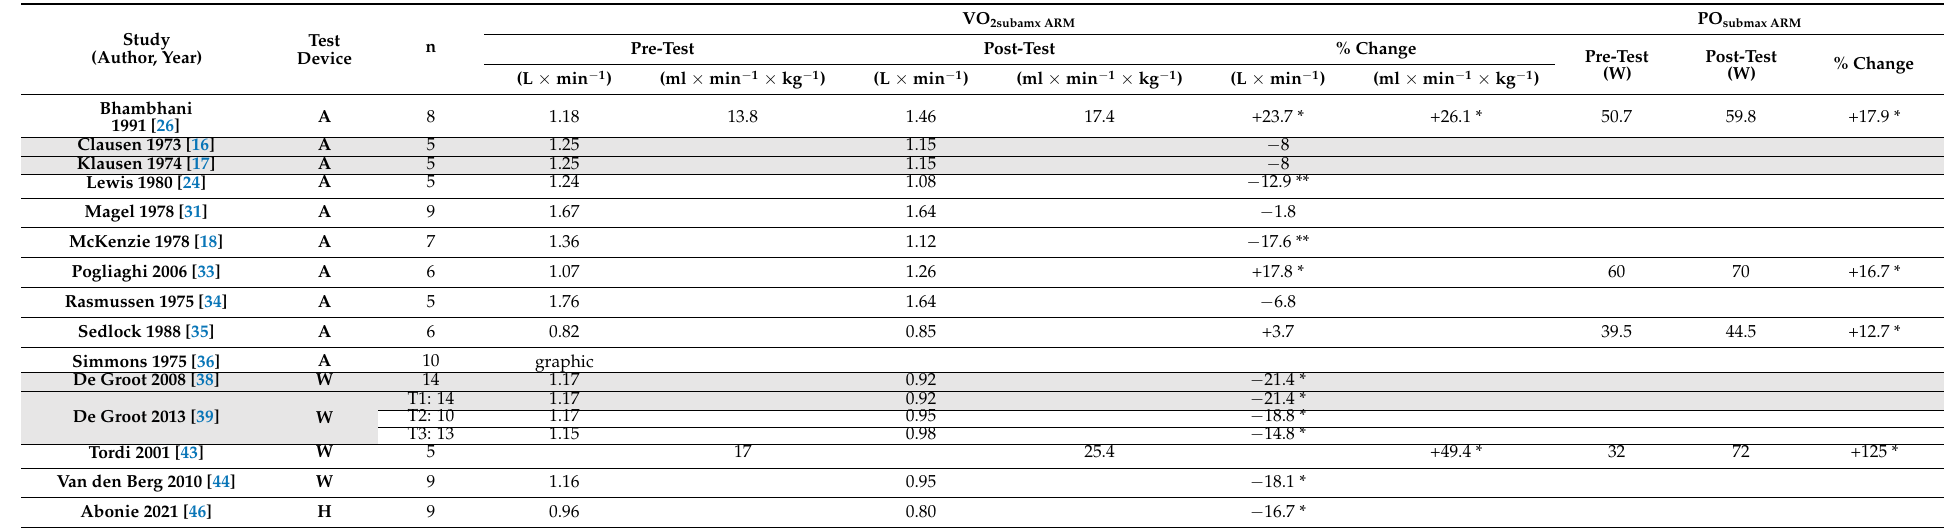
Table 5. Mean change in VO 2submax ARM and PO submax ARM between pre- and